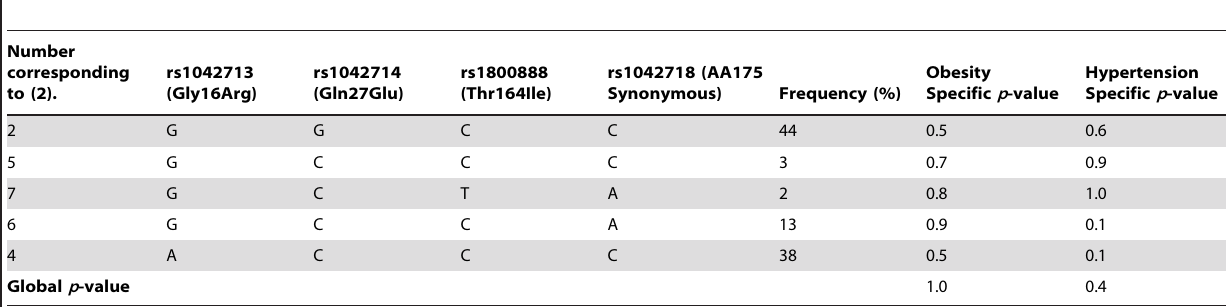
Table 1. ADRB2 haplotype analysis comparing obesity and hypertension status among 5,838 and 5,584 individuals from the Inter99 study sample, respectively.